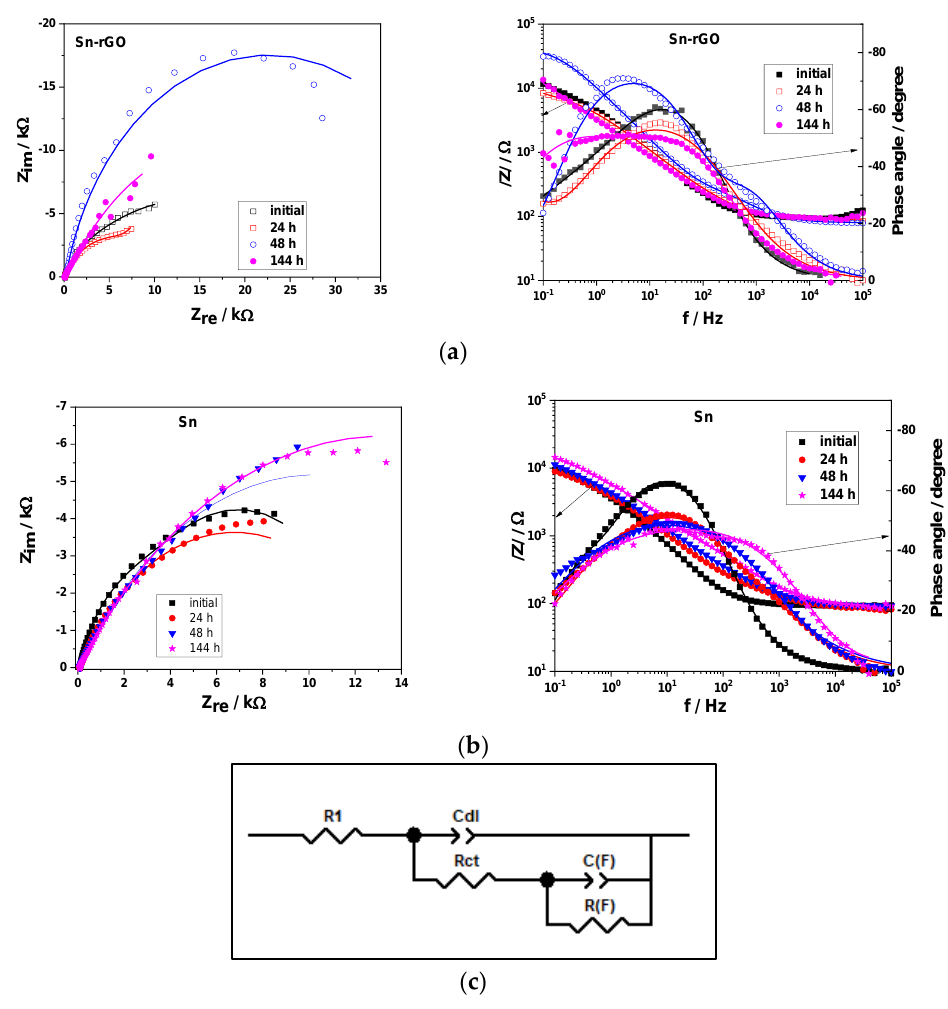
Figure 13. Nyquist (left) and Bode (right) plots for continuous immersion periods in 0.5 M NaCl: ( a )